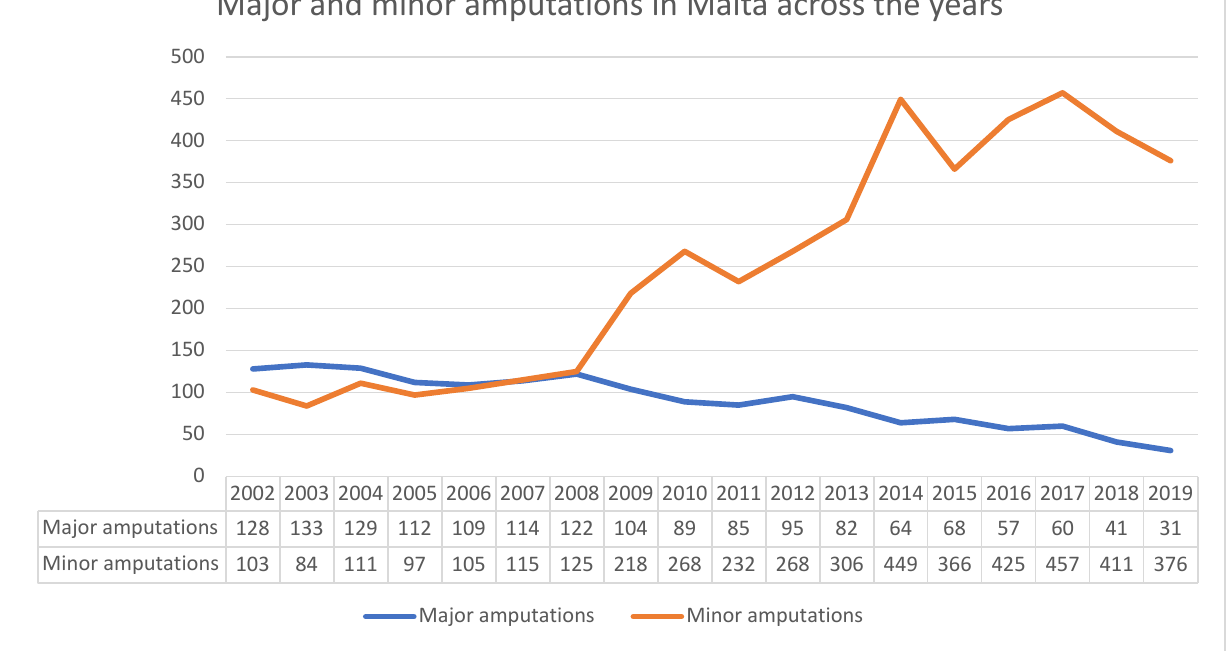
Figure 4. Comparison of major amputations (above ankle) with minor amputation rate (below ankle) between 2002 and 2019.